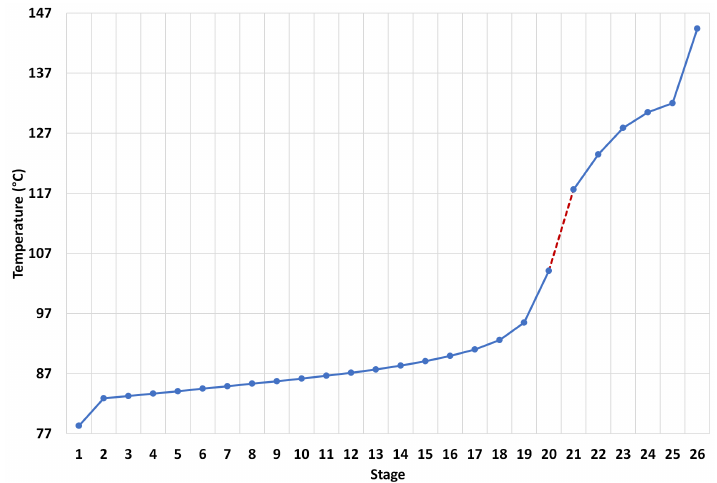
Figure 5. Temperature profiles of the salt extractive distillation